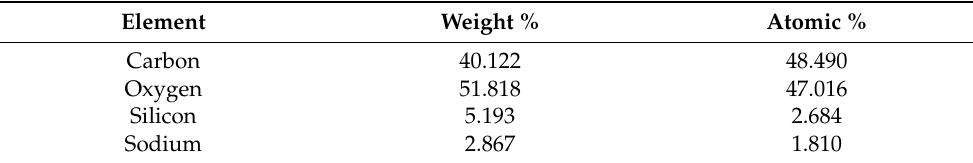
Table 1. Quantity of elemental composition in 2:1 molar ratio inulin–TEOS adsorbent.